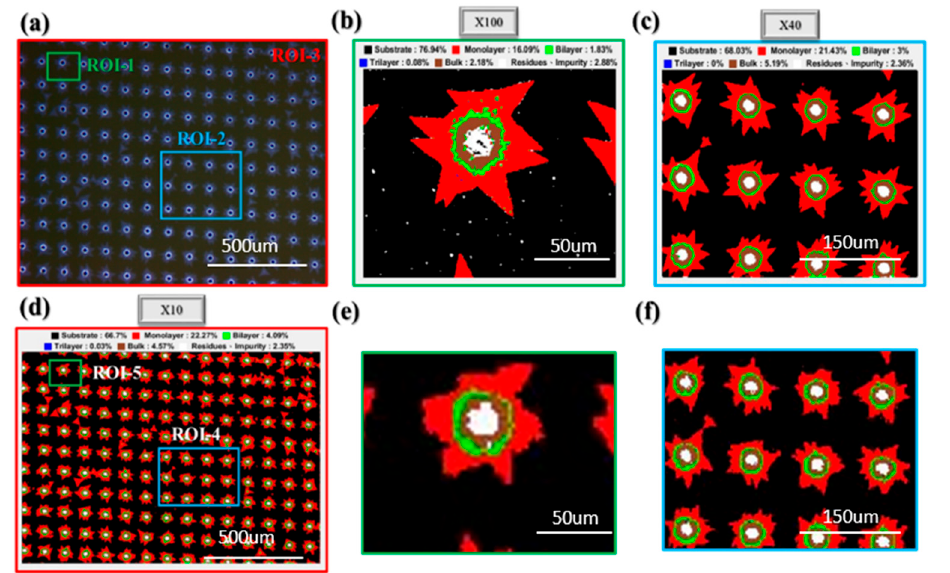
Figure 6. ( a ) OM images of the large-area periodic growth of single-layer MoS 2 on sapphire substrates at ( b ) 100× (ROI-1), ( c ) 40× (ROI-2), and ( d ) 10× (ROI-3) magnification rates. Color classification map predicted at 10× magnification: ( e , f ) are the amplification results of ROI-4 and ROI-5 ranges, respectively, corresponding to ROI-1 and ROI-2 circle selection.